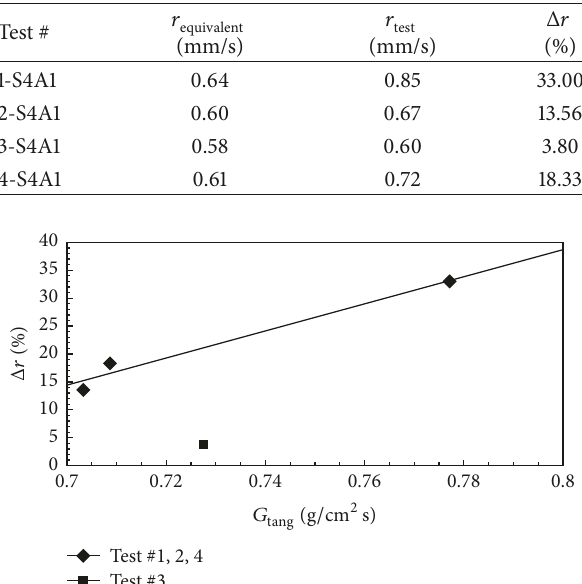
Table 7: Regression rate changes due to swirl flow.